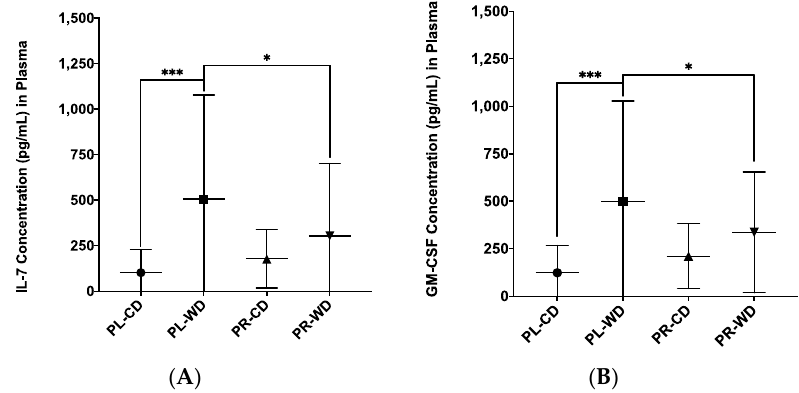
Figure 11. Treatment by diet interactions in plasma inflammatory analytes from factorial ANOVA analyses for ( A ) IL-7 and ( B ) GM-CSF. Data expressed as M ( SD ). * p < 0.05, *** p < 0.001. PL: placebo; PR: probiotic; WD: Western diet; CD: control diet.